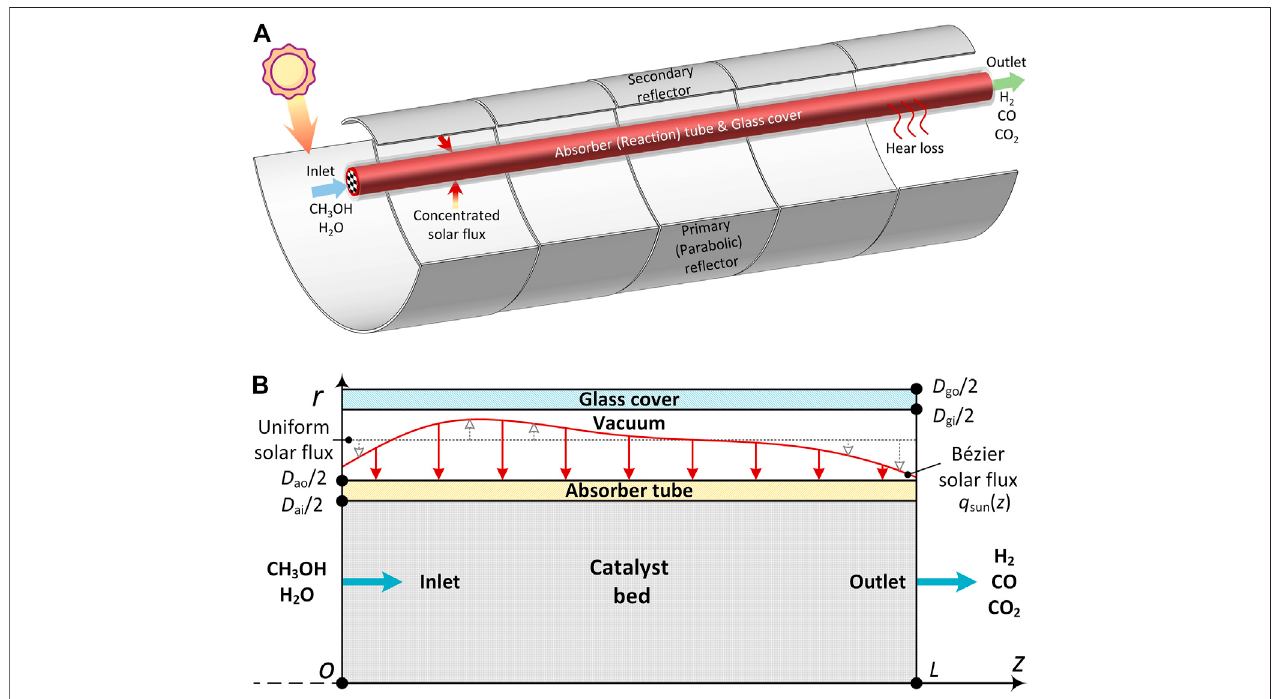
FIGURE 1 | Schematic diagram of (A) 3-D and (B) 2-D axisymmetric of the solar methanol steam reforming reactor.